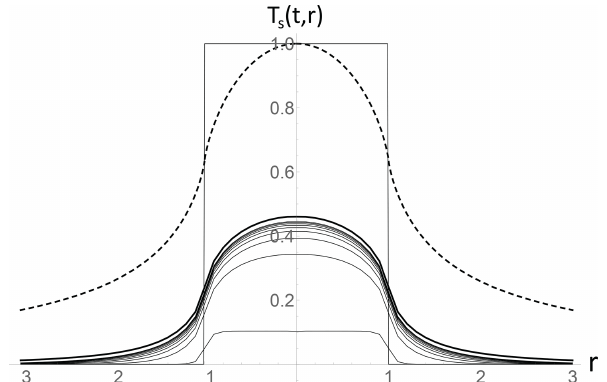
Figure 4. This is the step response in time and (circular) step in space for conductive–radiative forcing. Lines for t = 0.01 (bottom) and then for t = 0.2, 0.4, ... 1.6 (black, bottom to top; the thick black line is for t = ∞ or equilibrium). The nondimensional forc- ing is the rectangle (from unit circular forcing). Also shown (top dashed) is the equilibrium when the forcing is purely due to unit conductive heating over the unit